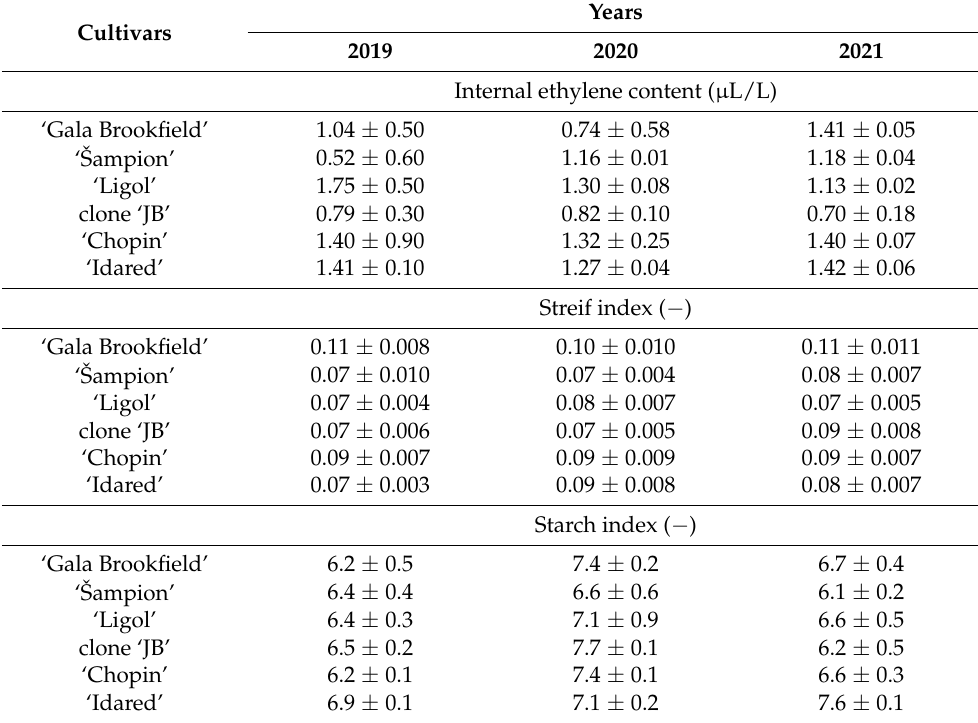
Table 1. Characteristic of the maturity stage of apples assessed directly after harvest.